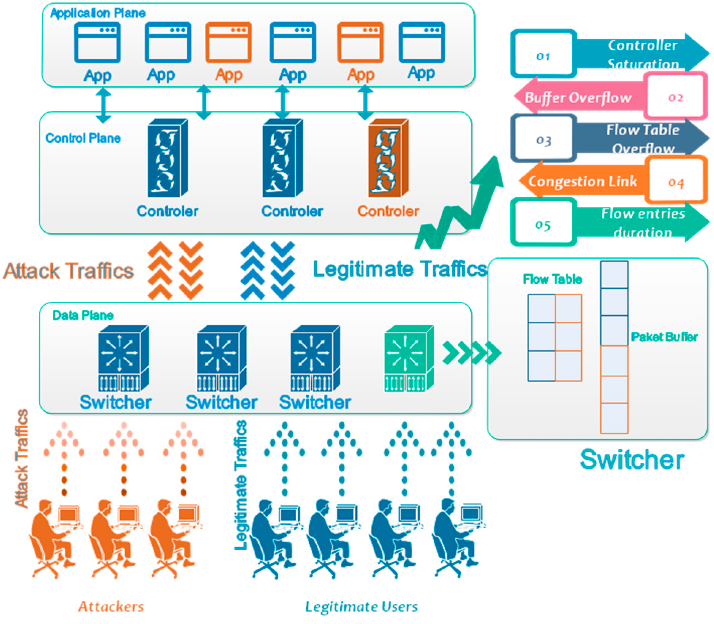
Figure 3. Flow description of DDoS A tt acks over an SDN architecture.